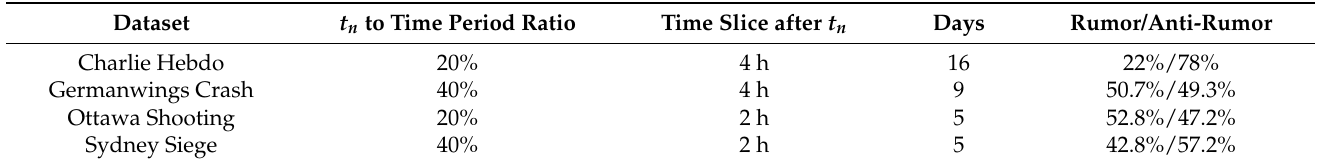
Table 2. Time segment division of the